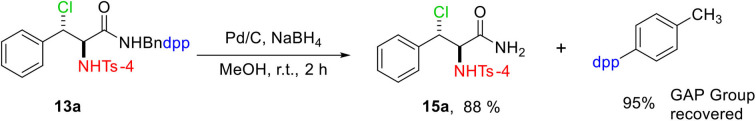
Group-assisted purification deprotection.